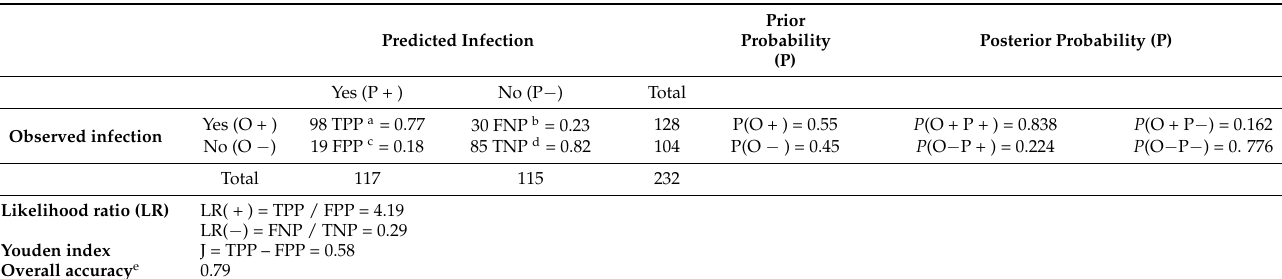
Table 4. Comparison between Ascochyta rabiei primary infections predicted by the model and observed on bait plants, and corresponding properties of the